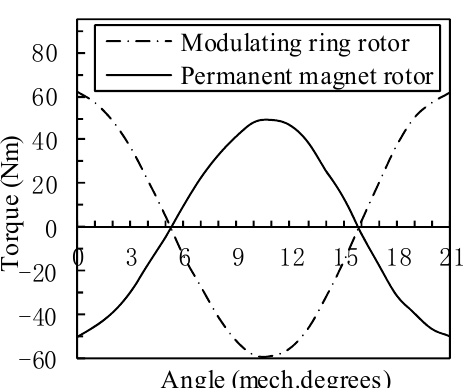
Figure 8. Torque-angle